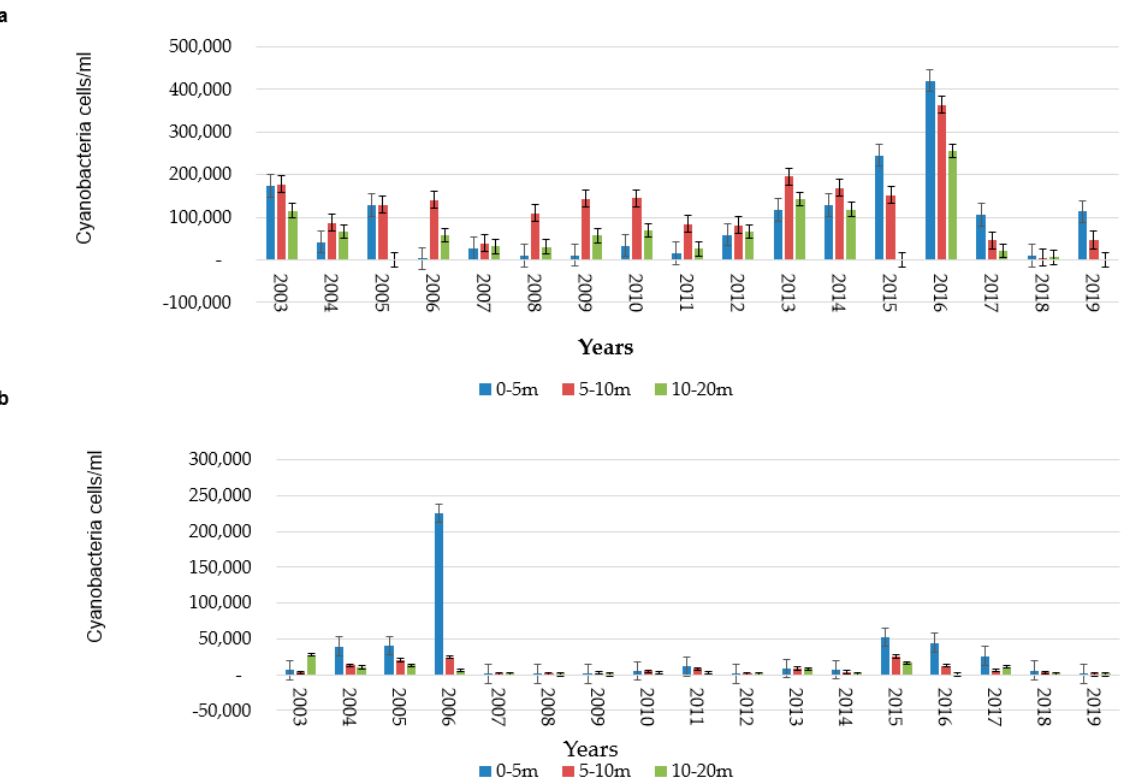
Figure 3. Yearly mean of cyanobacteria species cell counts in, ( a ) the Swakoppoort Dam and ( b ) the Von Bach Dam at different depths ranges from 2003–2019. Error bars indicate standard deviations.